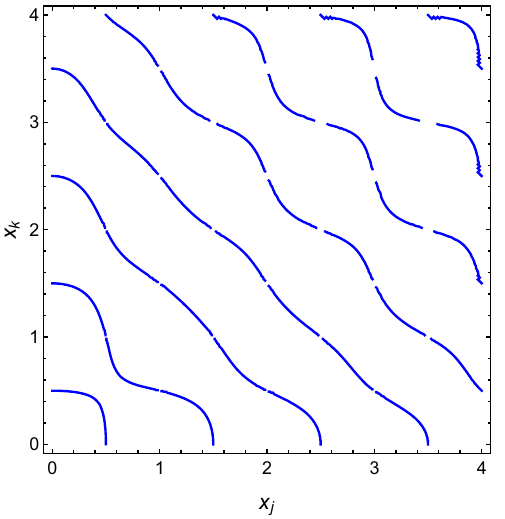
Fig. 1 Solutions of the transcendental Eq. (27) until x j ∼ x k ∼ 3 for δ = 1, for the thin-brane A